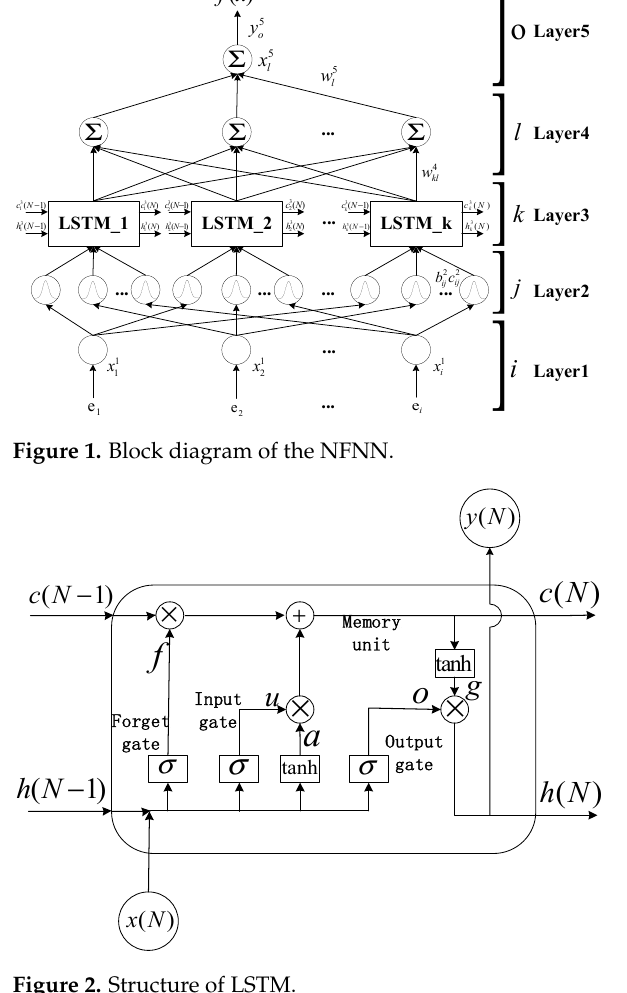
Figure 2. Structure of LSTM.